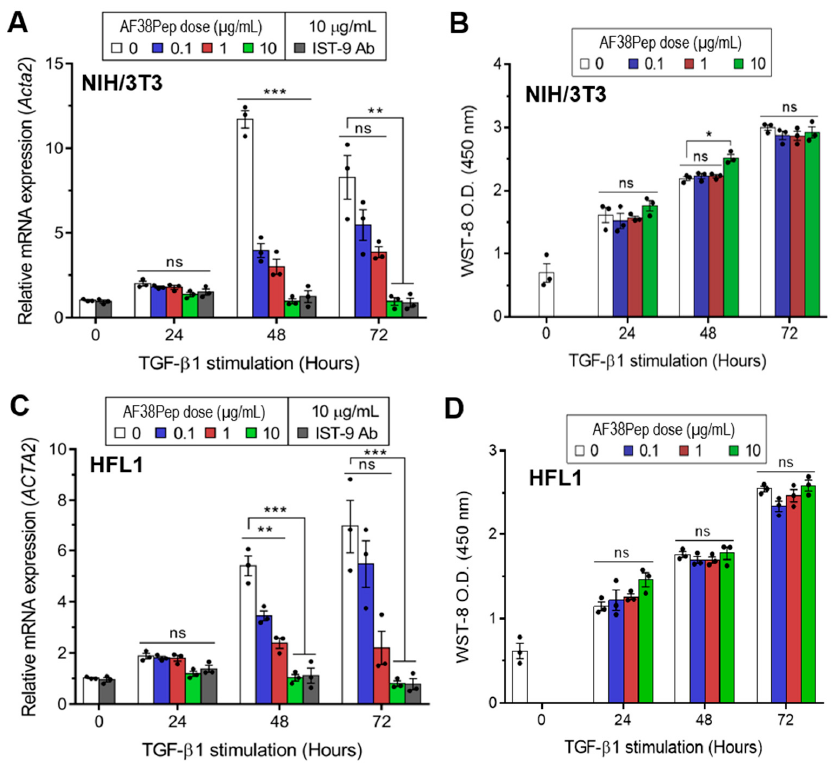
Figure 5. Cytocompatibility characteristics of the synthesized blocking polypeptide. ( A ) The ability for AF38Pep to attenuate transforming growth factor- β 1 (TGF- β 1) induced upregulation in expression of the myofibroblast marker, α -smooth muscle actin ( α -SMA), in mouse NIH/3T3 dermal fibroblast cells over 72 h. ( B ) Cytotoxicity/proliferation assays in TGF- β 1 stimulated mouse NIH/3T3 dermal fibroblast cells over 72 h. ( C ) The ability for AF38Pep to attenuate TGF- β 1 induced upregulation in expression of α -SMA in human HFL1 lung fibroblast cells over 72 h. ( D ) Cytotoxicity/proliferation assays in TGF- β 1 stimulated human HFL1 lung fibroblast cells over 72 h. IST-9 antibody was used as a positive control for EDA-FN blockade. Data are representative of three independent experiments and displayed as the mean ± S.E. Statistical analysis is shown as *** p ≤ 0.001, ** p ≤ 0.01, * p ≤ 0.05, and ns = no statistical significance ( p > 0.05).